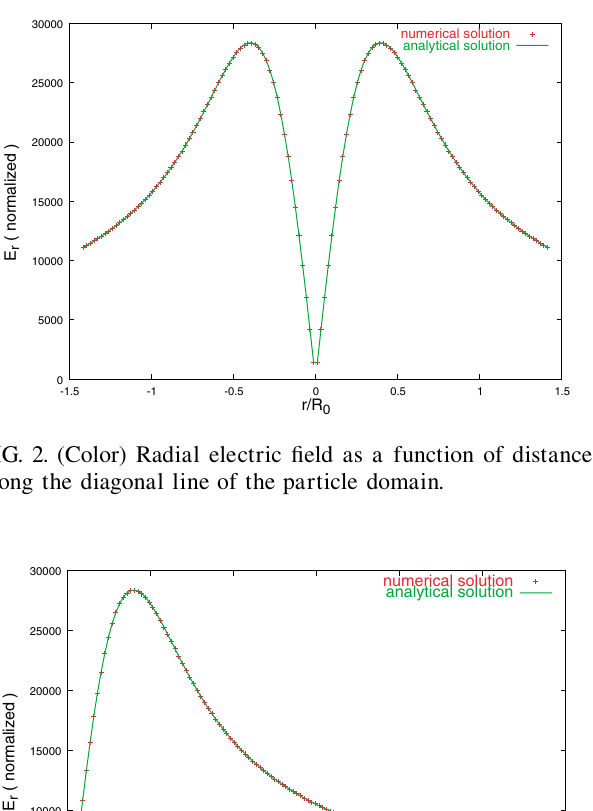
FIG. 1. A schematic plot of the particle domain and the field domain.